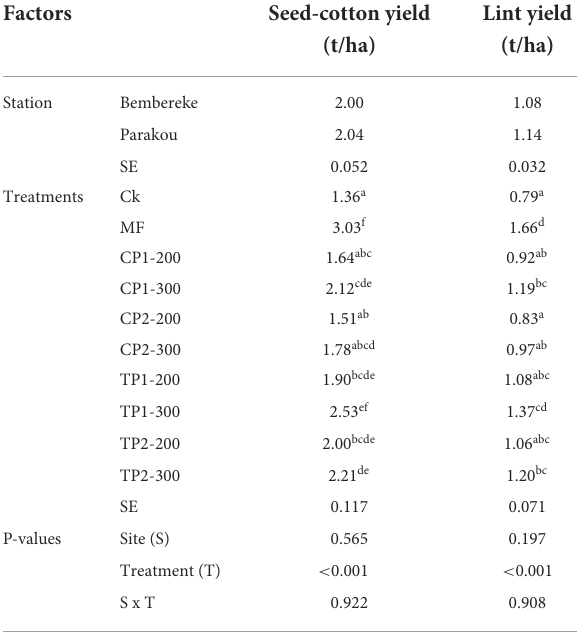
TABLE 4 Effect of different biochar-based amendments on seed-cotton and lint yields at the two on-station experimental sites in northern Benin.